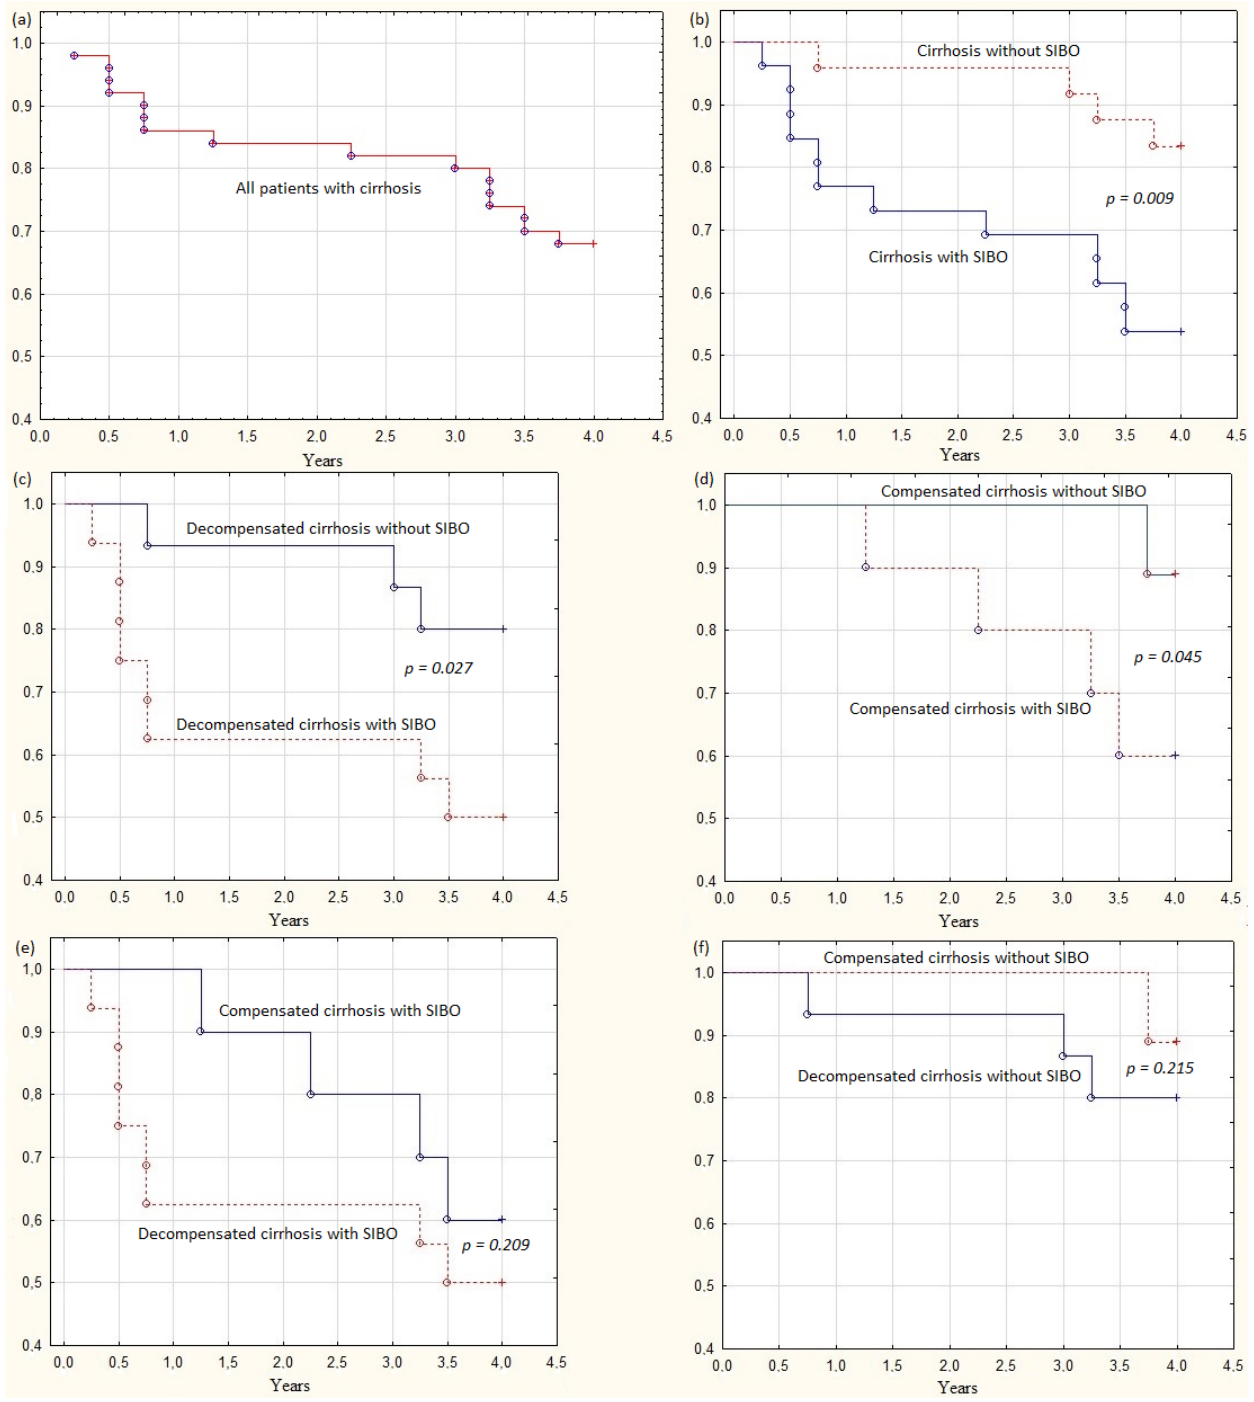
Figure 2. Survival curves of patients: ( a ) all patients; ( b ) cirrhosis with small intestinal bacterial overgrowth (SIBO) and without SIBO; ( c ) decompensated cirrhosis with and without SIBO; ( d ) compensated cirrhosis with and without SIBO; ( e ) patients with SIBO and with compensated and decompensated cirrhosis; ( f ) patients without SIBO with compensated and decompensated cirrho ‐ sis.